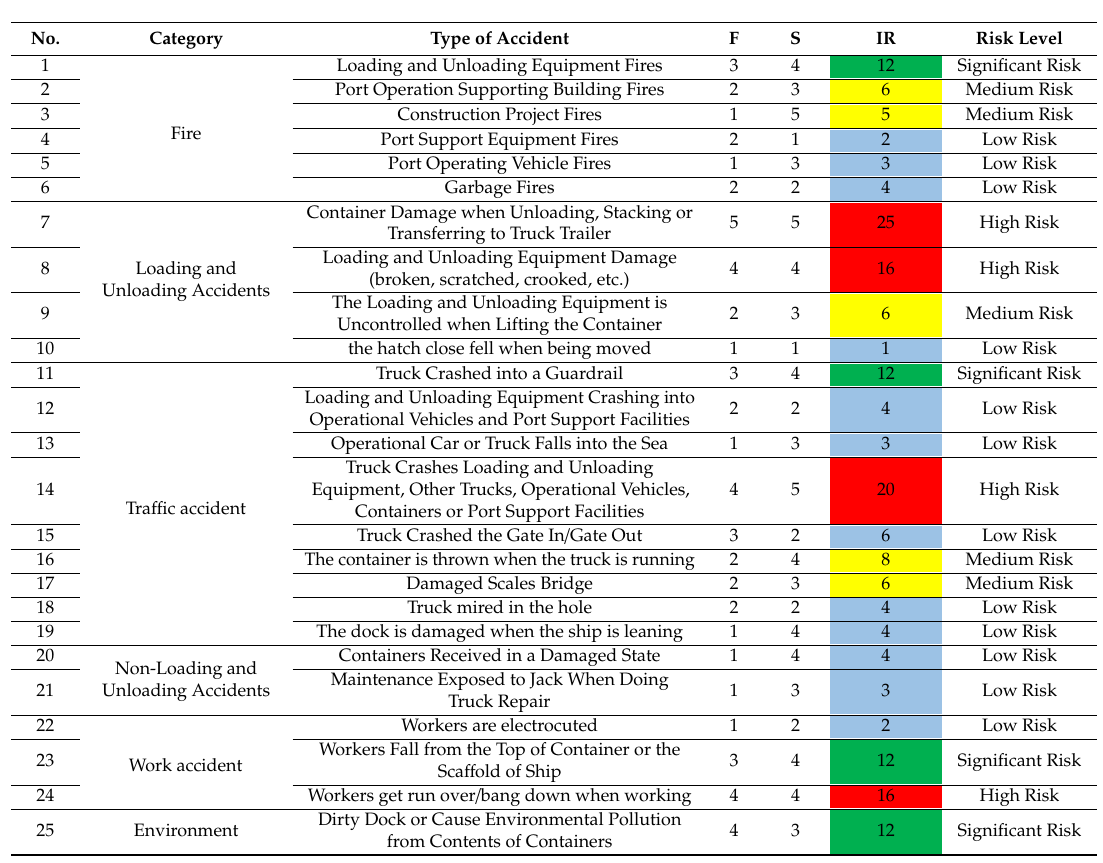
Table 4. Risk Assessment Results.